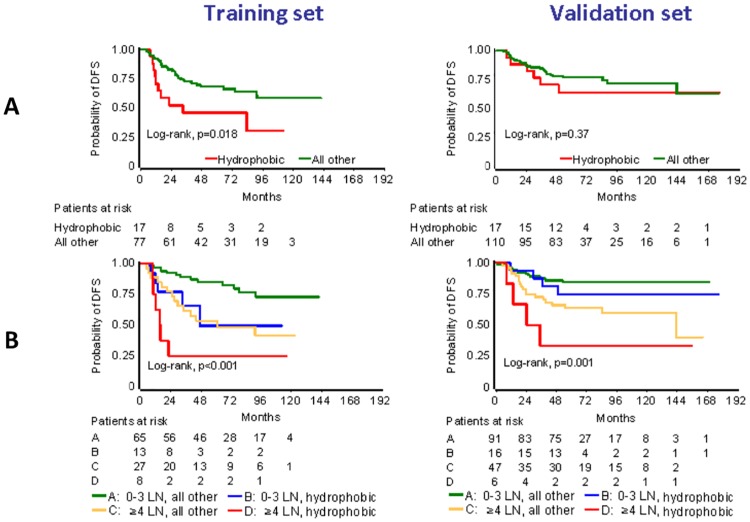
Hydrophobic mutations adversely affect patient DFS.Analysis was conducted in non-LPBC (tumors with <50% TILs). LN in B: nodal status. Patients with tumors with hydrophobic mutations performed worse in every context, in both cohorts.